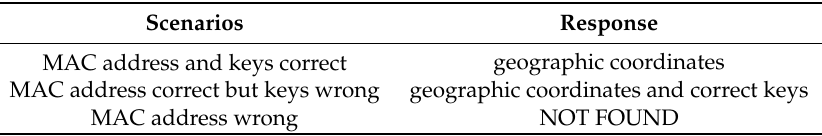
Table 4. Response format from the www.a.com